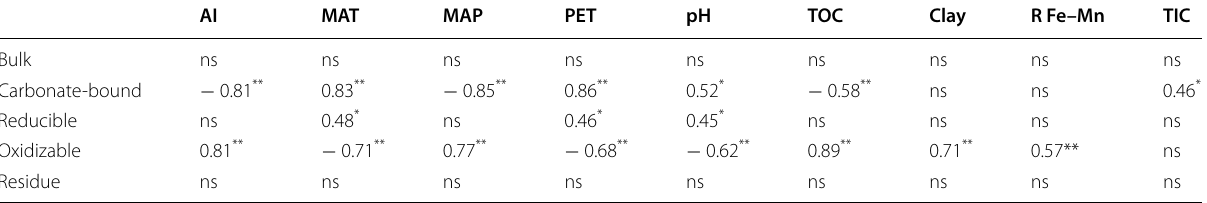
Table 1 Pearson correlation coefficients between climate factors and soil properties with REE concentrations (μg g − 1 ) of bulk and geochemical fractions in topsoils (0–10 cm) along the transect. Locations of the sites (S01–S21) are plotted in Fig.